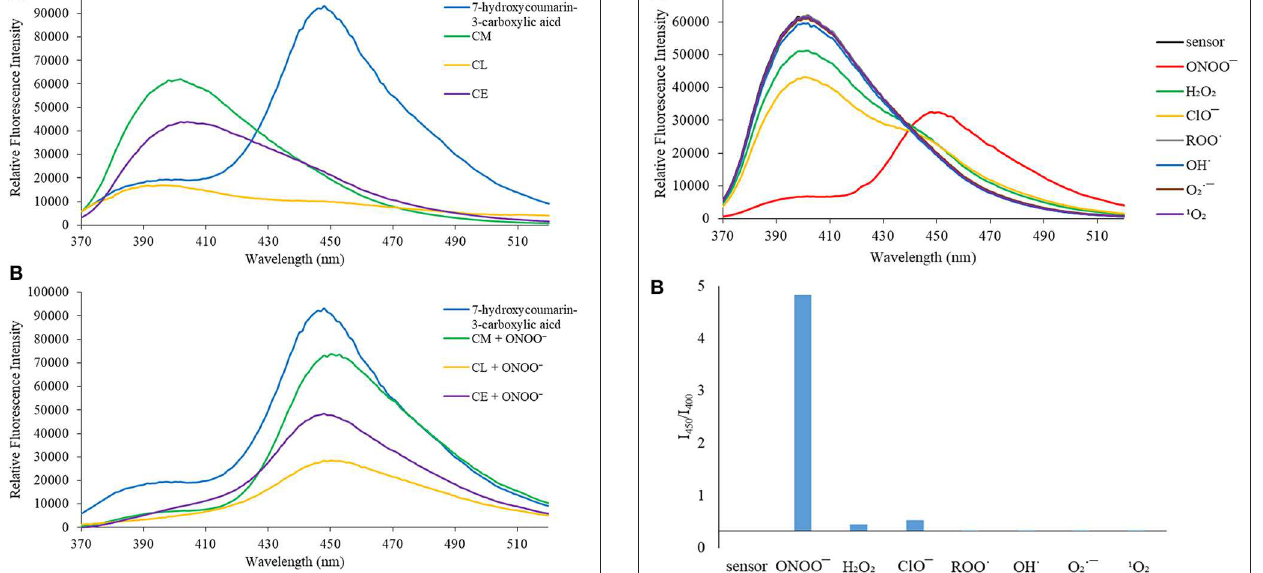
FIGURE 2 | (A) Selectivity data for CM (5 µ M): emission spectrum in the presence of ONOO − (50 µ M), OH · (500 µ M), O ·− 2 (500 µ M), 1 O 2 (500 µ M) after 5min. H 2 O 2 (1mM), ROO · (500 µ M) and ClO − (500 µ M) were measured after 30min. The data was obtained in PBS buffer, pH = 7.4 at 25 ◦ C at λ ex = 340 (bandwith: 20) nm on a BMG Labtech CLARIOstar ® plate reader. (B) Selectivity data for CM (5 µ M): relative intensity ratio in the presence of ONOO − (50 µ M), OH · (500 µ M), O ·− 2 (500 µ M), 1 O 2 (500 µ M) after 5min. H 2 O 2 (1mM), ROO · (500 µ M) and ClO − (500 µ M) were measured after 30min. The data was obtained in PBS buffer, pH = 7.4 at 25 ◦ C at λ ex = 340 (bandwith: 20) nm on a BMG Labtech CLARIOstar ® plate